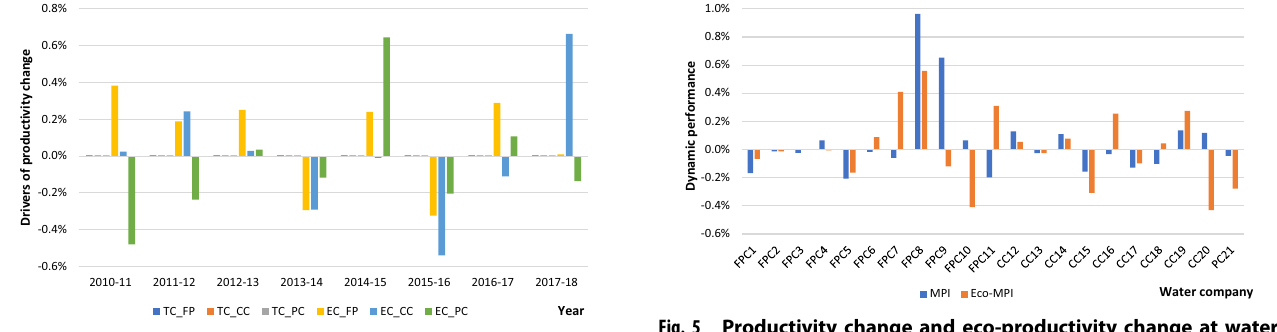
Fig. 3 Drivers of productivity change of Chilean water companies. Average estimates of technical change (TC) and ef fi ciency change (EC) for productivity change (MPI) of Chilean water companies by ownership.